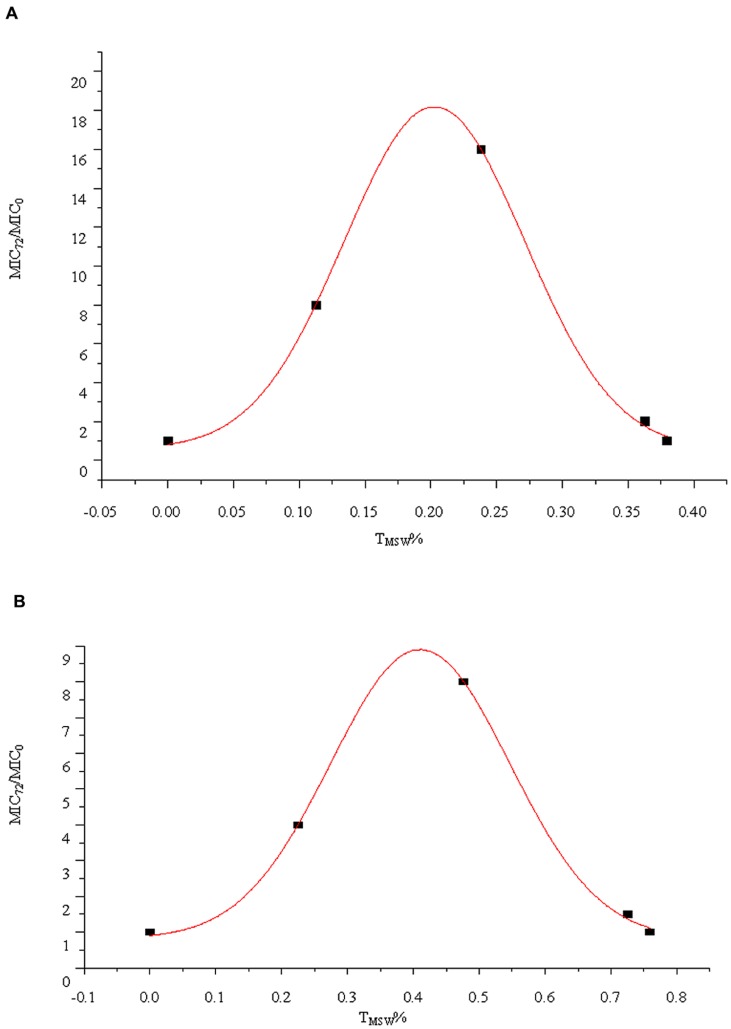
Relationship between the TMSW% and MIC72/MIC0 for S. aureus ATCC 25293 exposed to cefquinome in the in vitro model with two terminal half-lives (t1/2β). (A) t1/2β = 3 h, (B) t1/2β = 6 h.